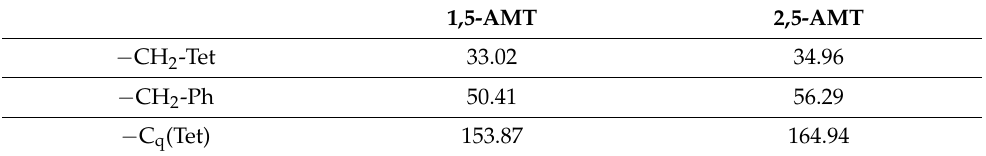
Table 2. 13 C Chemical shift assignments (in ppm) in 1,5- and 2,5-AMTs derivatives (DMSO- d 6